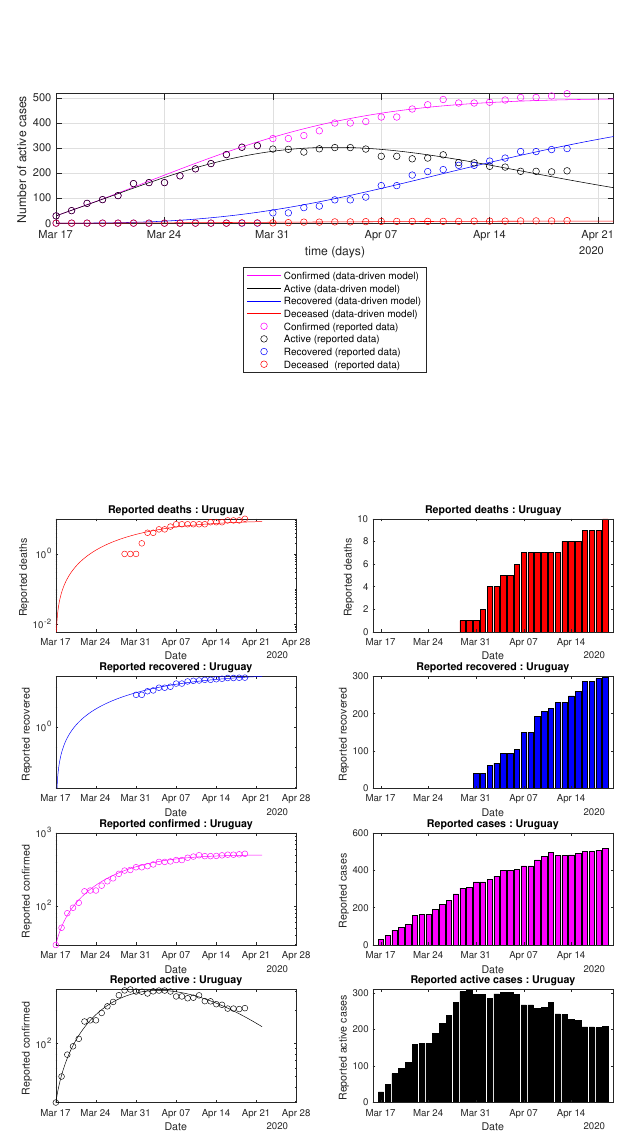
Figure 28. Uruguay: data of active, recovered, deceased (in circle or bar) vs. model of active, recovered, deceased over time. Tracking the number of active cases. Predictive analytics for the next couple